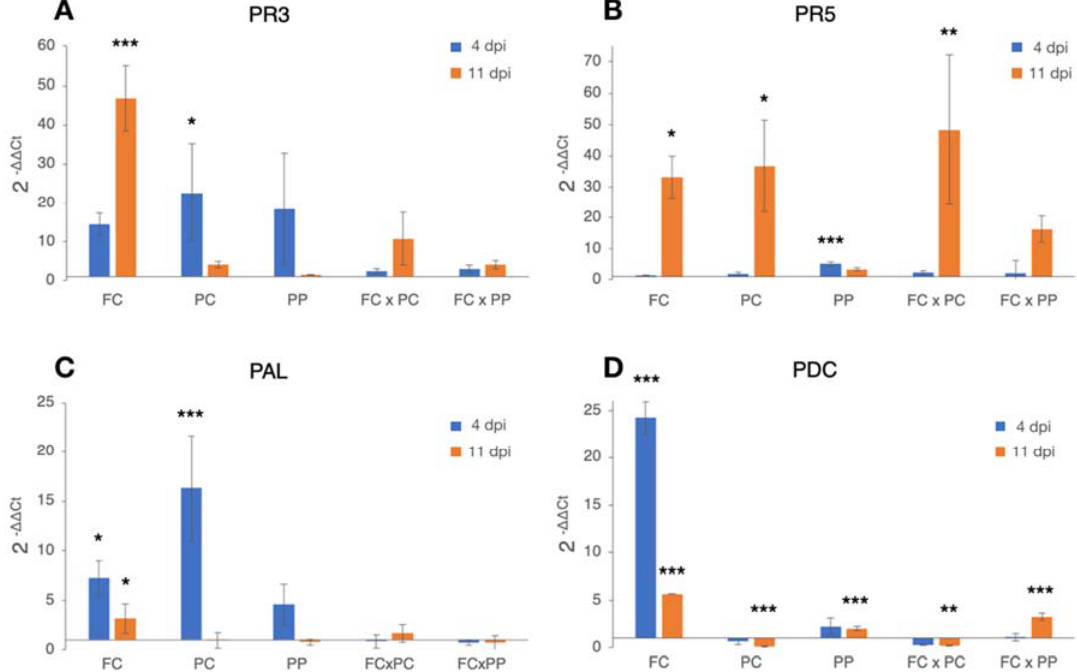
Figure 3. Differences in the expression levels of PR3- ( A ), PR5- ( B ), PAL- ( C ) and PDC- ( D ) -encoding genes in Pinus radiata seedlings at 4 (blue bars) and 11 (orange bars) days-post-inoculation (dpi) with Fusarium circinatum (FC), P. xcambivora (PC), P. parvispora (PP), F. circinatum ∗ P. xcambivora (FC × PC) and F. circinatum ∗ P. parvispora (FC × PP). Columns with asterisks are statistically different according to Dunnett’s test (* p < 0.05, ** p < 0.01, *** p < 0.001), compared with their calibrator (i.e., wounded and non-inoculated control seedlings).